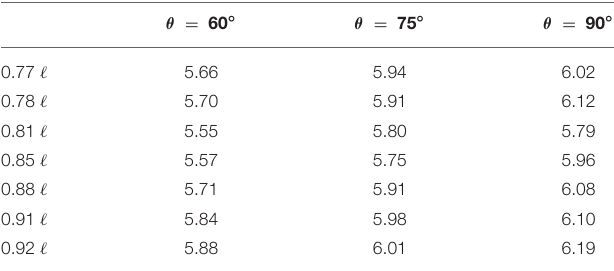
TABLE 1 | Energy loss rate in mW from 21 configurations of “physiological” Fontan as predicted by CFD.